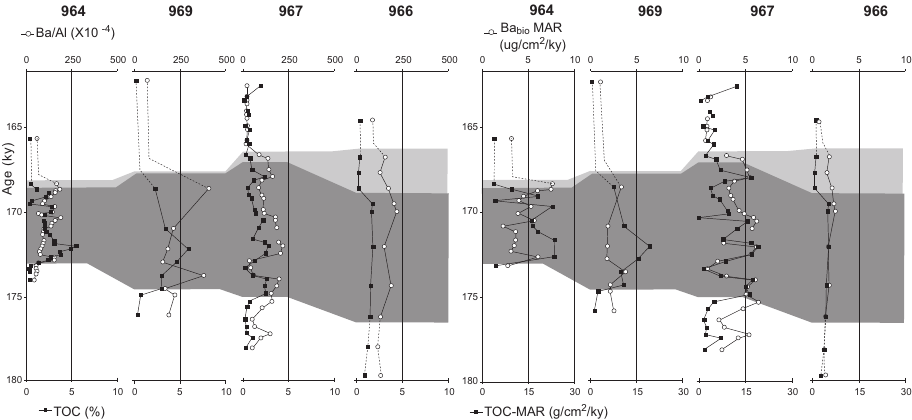
Fig. 4. Comparison of TOC and Ba/Al vs. TOC-MAR and Ba bio MAR for S6 on all studied sites. Dark shade corresponds to visible sapropel layer. Light shade represents oxydized sapropel.